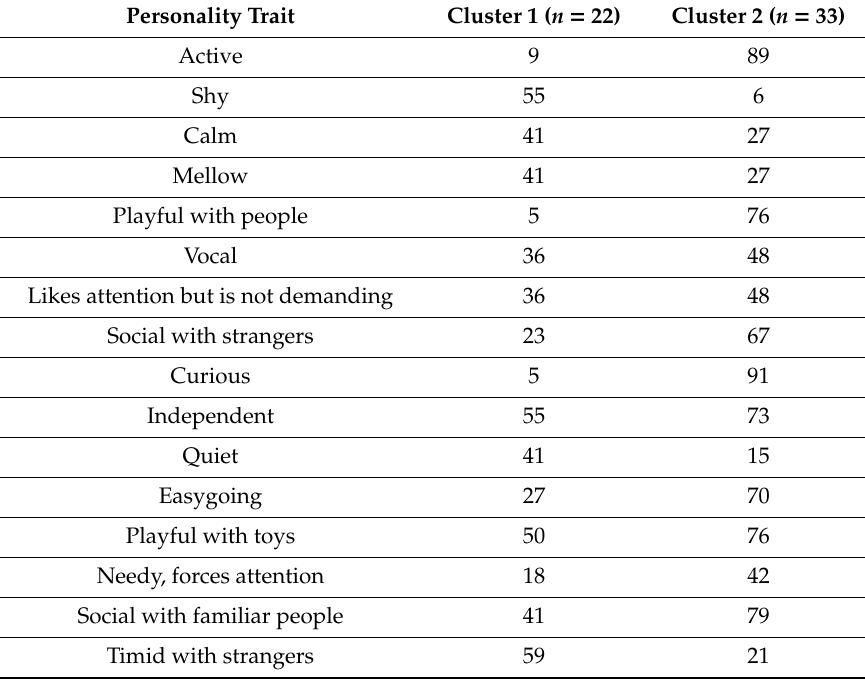
Table 1. Percentage of cats rated by their guardians with each personality trait.